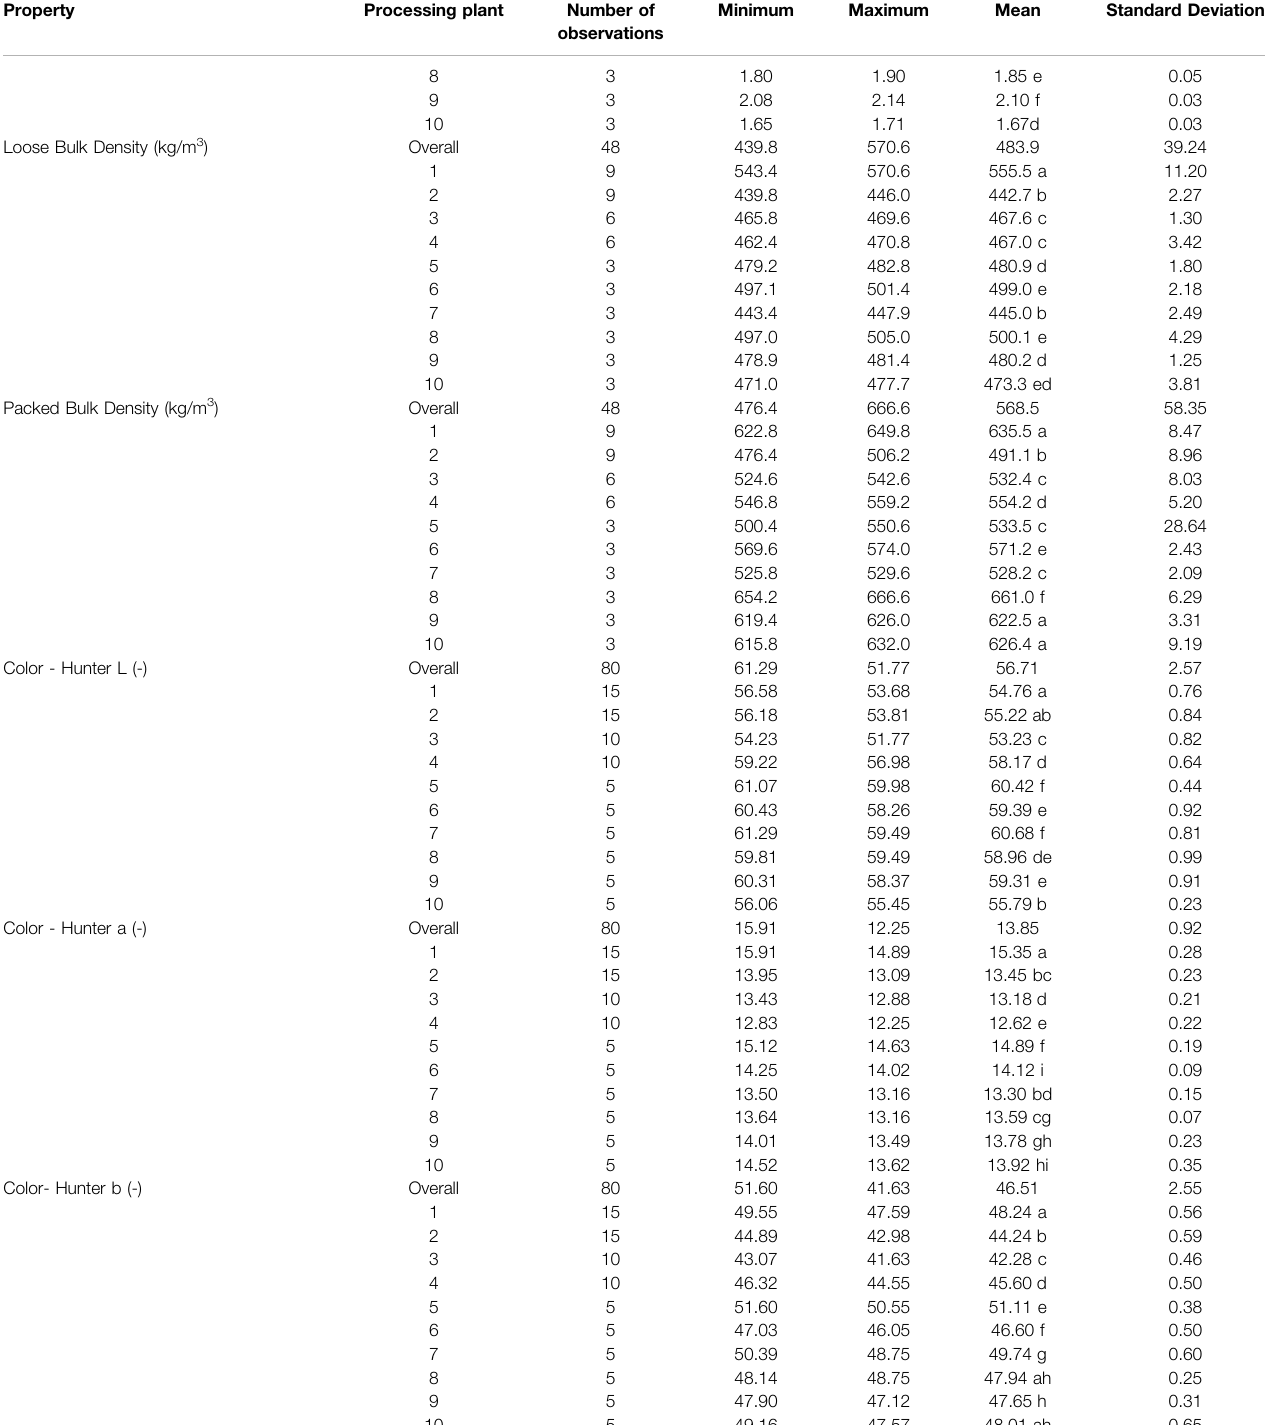
TABLE 1 | ( Continued ) Physical and fl ow properties of distillers dried grains with solubles (DDGS). a